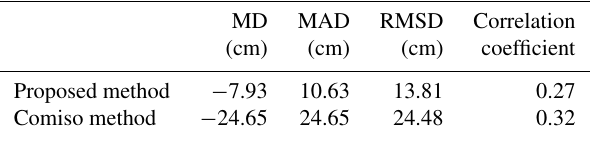
Table 4. The comparisons between the OIB snow depth and the snow depth estimates from the proposed method and the Comiso method in October and November 2011. MD: mean difference; MAD: mean absolute